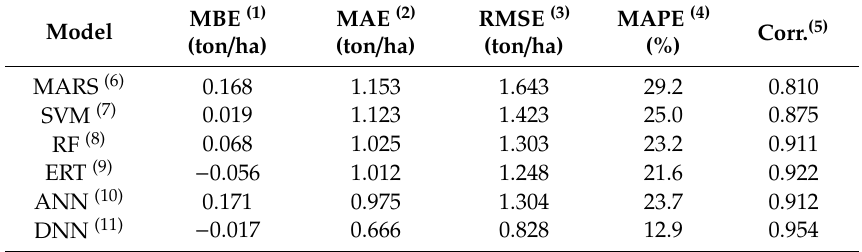
Table 4. Summary of validation statistics for prediction of corn yield in 2012 as a drought case. MBE (1) MAE (2) RMSE (3) MAPE (4) Model Corr. (5) (ton / ha) (ton / ha) (ton / ha) (%) 0.168 1.153 0.019